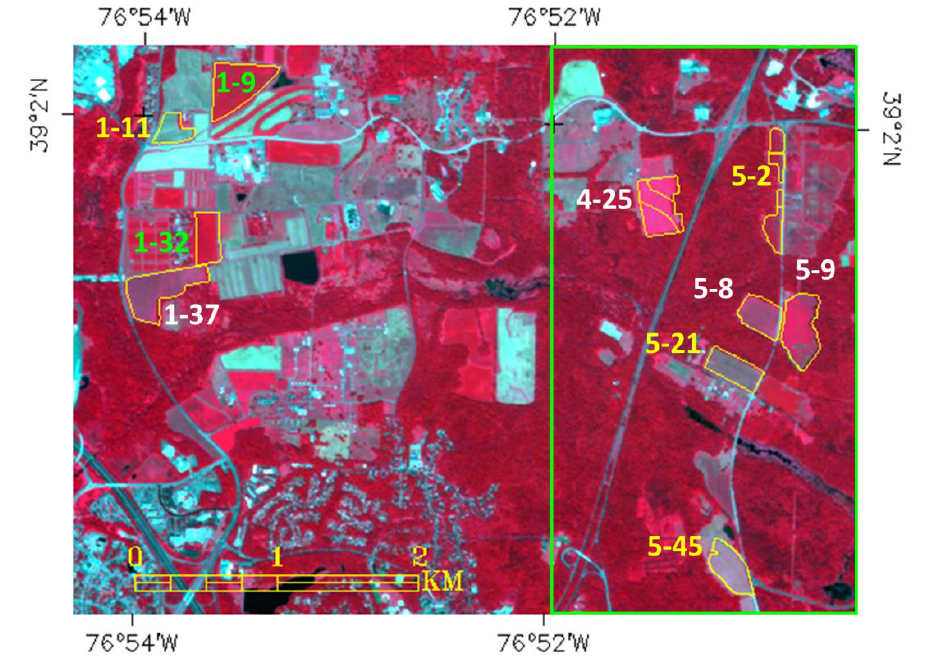
Figure 3. Cover crop fields (yellow polygons) in 2019 (yellow and white labels, 8 fields) and 2020 (green and white labels, 6 fields) over BARC were used in the validation. Four fields (white labels) planted cover crops in both years. Fields #1-37, #4-25, #5-8, and #5-9 (white labels) were planted with cover crops in both years. A total of 29 termination records for these fields in 2019 and 2020 were extracted. The text label near the field shows the field name used in BARC. The green rectangle is the sub-area for displaying near-real-time mapping detailed in Section 4.4. The basemap is a VENµS false color composite image (Red: near-infrared band; Green: red band; Blue: green band) acquired on 13 July 2019.